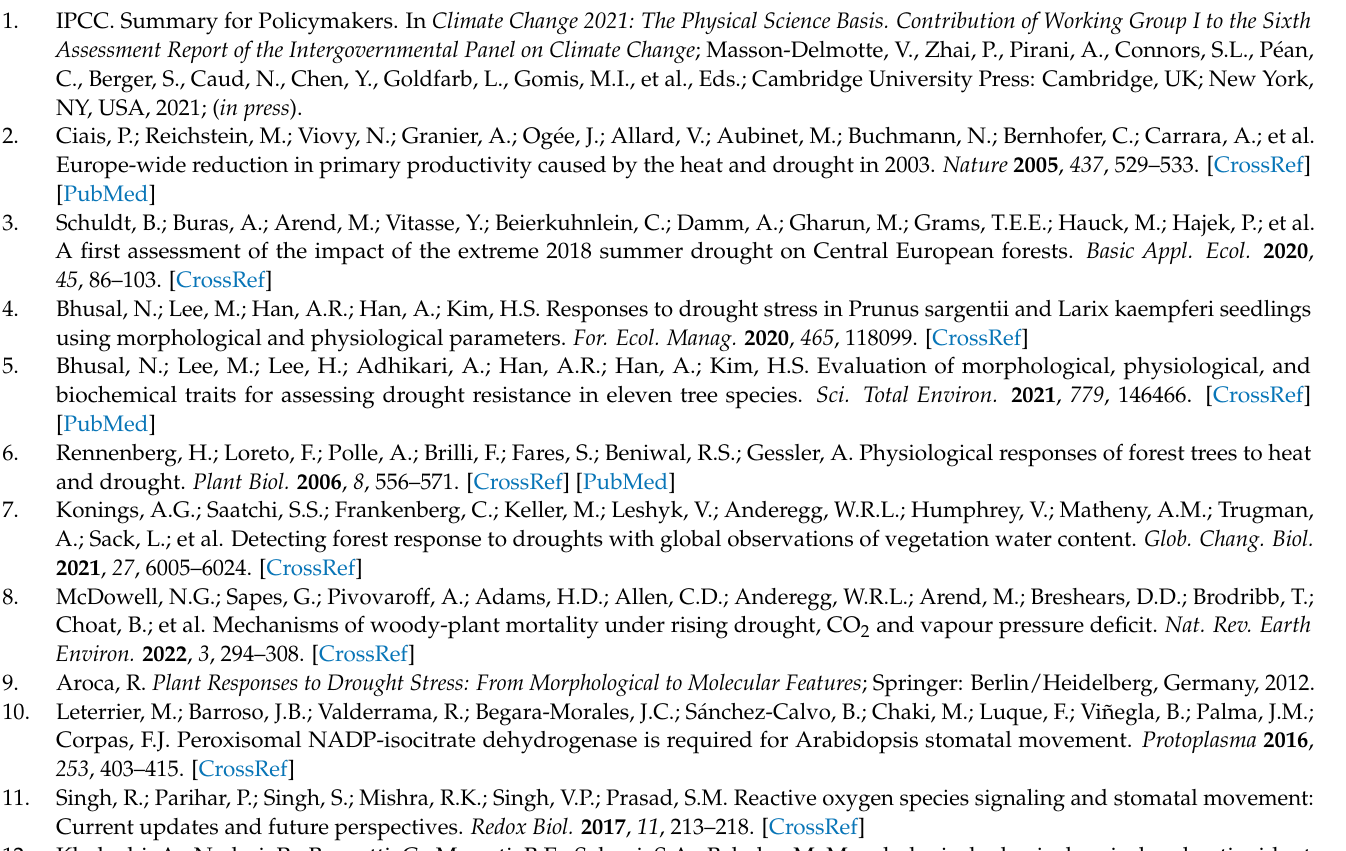
Figure S17: δ 13 C signatures in leaves (F) and roots (R) of European beech after two years of growth in mixed cultivation with silver fir (left panel) as dependent on the number of fir neighbours (right panel); Figure S18: δ 13 C signatures in current year (0yn, CN) and previous year (1yn, PN) needles and roots (a) of silver fir after two years of growth in mixed cultivation with European beech as dependent on the number of beech neighbours (b). -Water: Beech/fir mixtures exposed water deprivation and rewatering during the first year of growth. Data shown are means ± SD (n = 74–80). Significant differences are shown by different letters ( p <